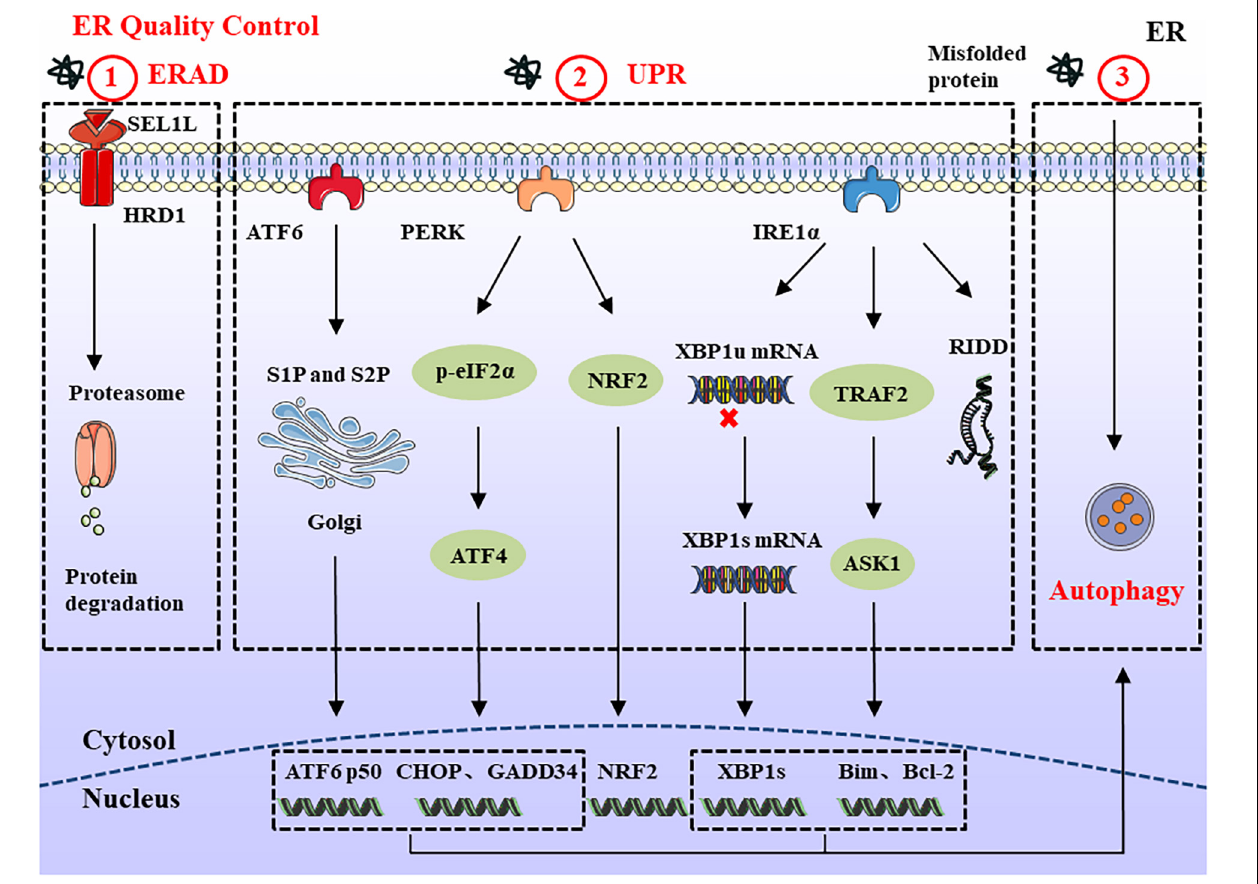
FIGURE 1 | ERQC in Endoplasmic reticulum. ERQC monitors the correct folding of proteins via ERAD, UPR, and autophagy. (1) The soluble protein aggregates are retrotranslocated into cytosol through SEL1L-HRD1, where the ubiquitinated substrates are degraded by the proteasome. (2) When the misfolded proteins exceed ER degradation capacity, it leads to the ER stress response. In order to maintain ER homeostasis, the UPR response is activated which is composed of IRE1 α , PERK, and ATF6 branches. The activated IRE1 α catalyzes the splicing of XBP1 to generate XBP1s. In addition, IRE1 α can also reduce protein synthesis through RIDD, and interacts with TRAF2 to regulate the expression of pro-/anti-apoptotic proteins. PERK reduces protein load by phosphorylating eIF2 α and NRF2. Meanwhile, the upregulated ATF4 participates in cell apoptosis and protein synthesis via CHOP and GADD34. ER stress also causes the translocation of ATF6 to